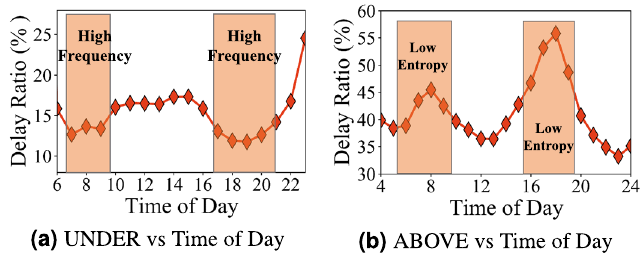
Figure 8. Delay distribution during one day; ( a ) underground travel delay is dominated by train frequency; ( b ) aboveground travel delay is dominated by spatial entropy.